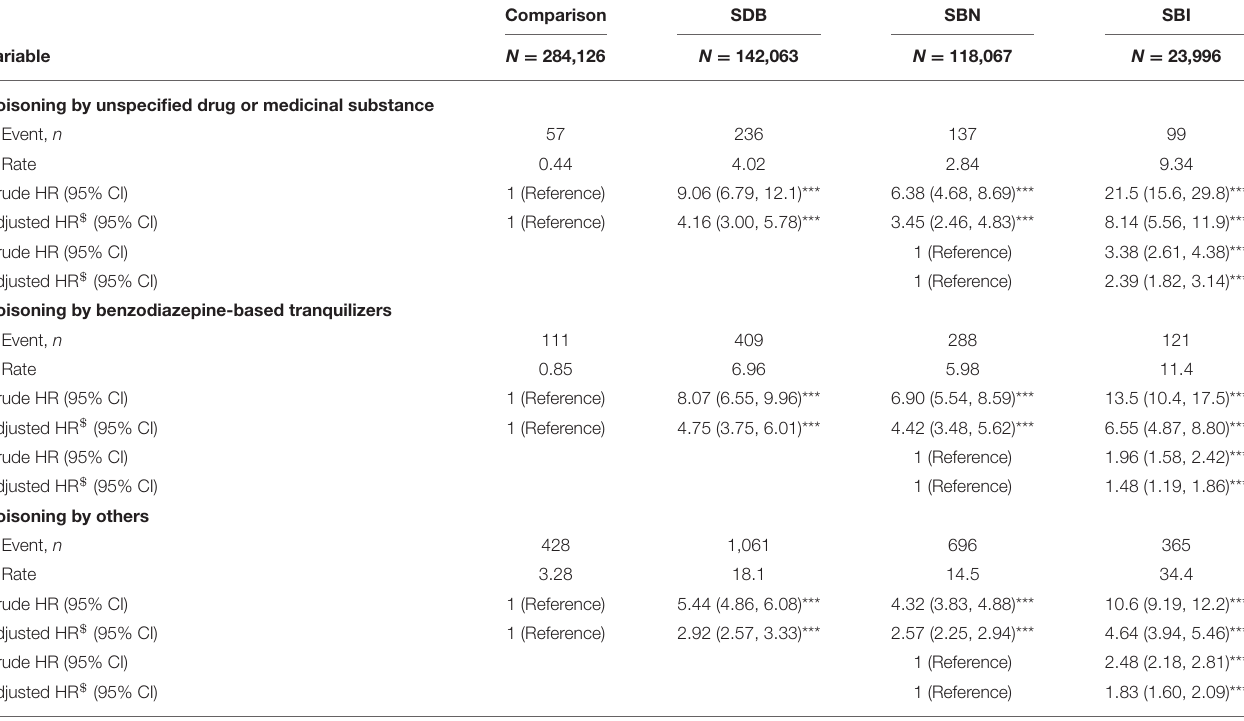
TABLE 5 | Incidence of different ways of suicidal drug overdose (per 10,000 person-years) and hazard ratios estimated through the Cox method in patients with SDB with or without head trauma.